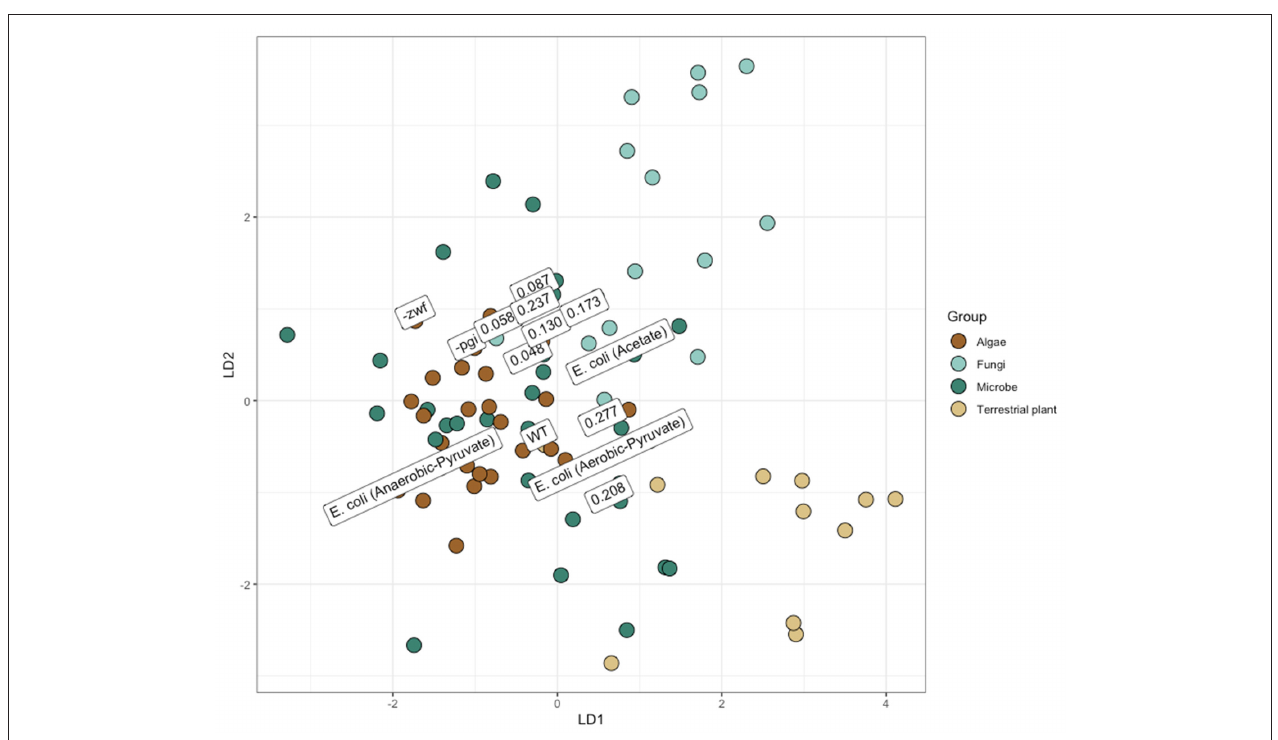
FIGURE 6 | Linear discriminant analysis (LDA) projection, similar to those used for amino acid fingerprinting. Mixing of major groups may partially result from lack of an extensive variable selection/model development process. However, delineations of major groups and differences between metabolisms (anaerobic vs. aerobic Escherichia coli growth) are evident. Overall, identification accuracy from leave-one-out validation was 66%. Data from E. coli, from this study, are labeled with either their dilution rate or the strain. The position of points has been slightly adjusted to improve legibility. Other samples of E. coli previously analyzed for the carbon isotope composition of amino acids, in the literature, are identified with “ E. coli (Growth